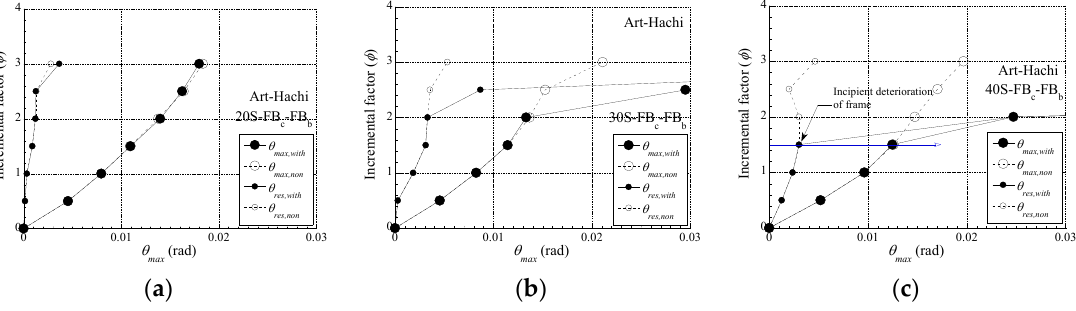
Figure 11. Incremental maximum and residual story drift angles of 20S building models. ( a ) 20S ‐ FB c ‐ FB b ; ( b ) 30S ‐ FB c ‐ FB b ; ( c ) 40S ‐ FB c ‐ FB b .